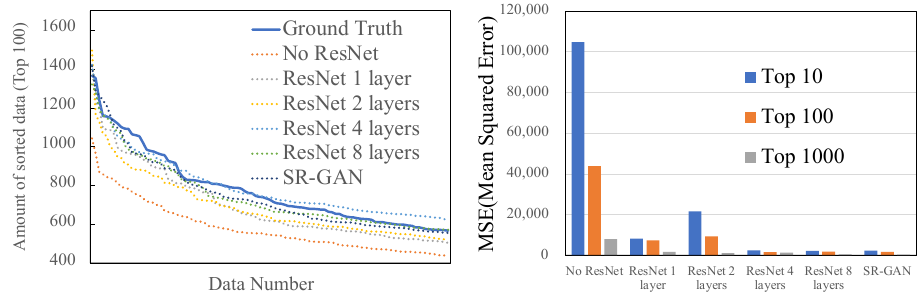
Figure 5. Top 100 traffic data volume scores sorted by volume, and the top 10, 100, and 1000